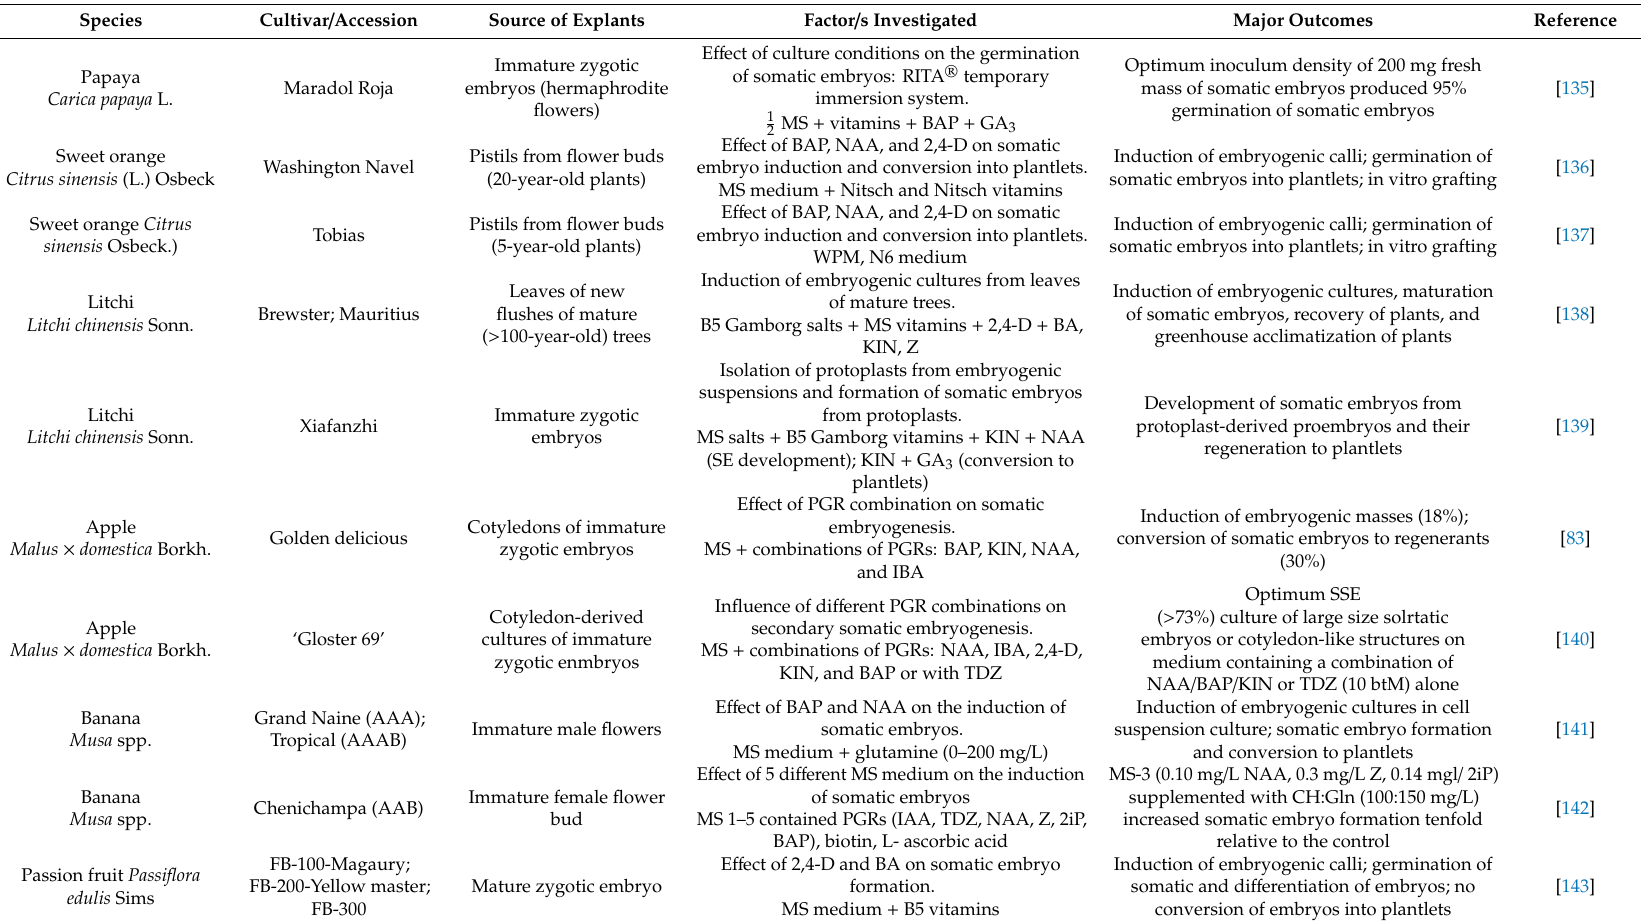
Table 3. Cytokinin applications in mass propagation of major horticultural fruit species through somatic